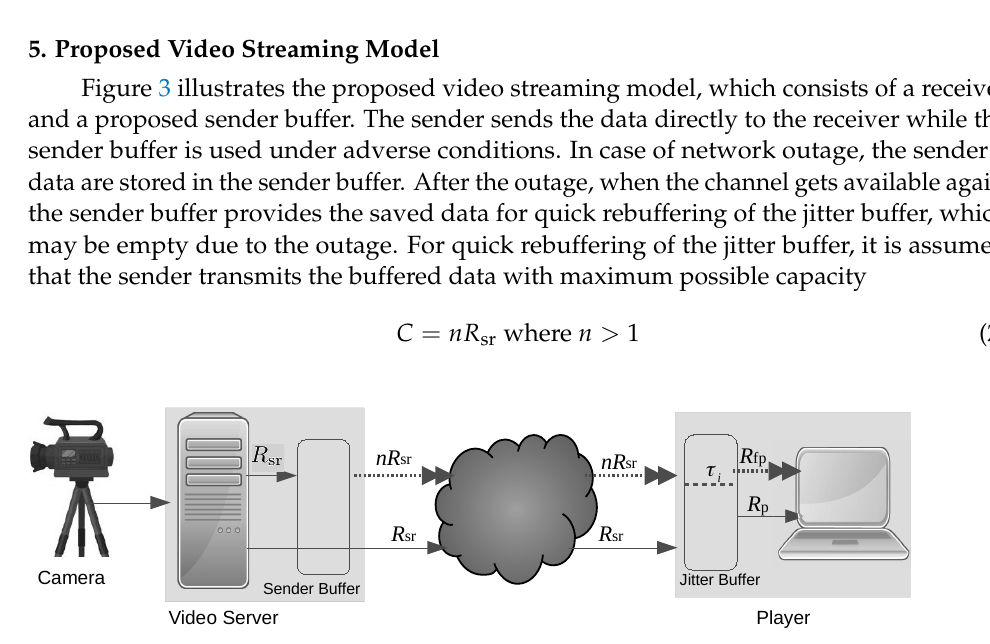
Figure 3. Proposed video streaming model with sender